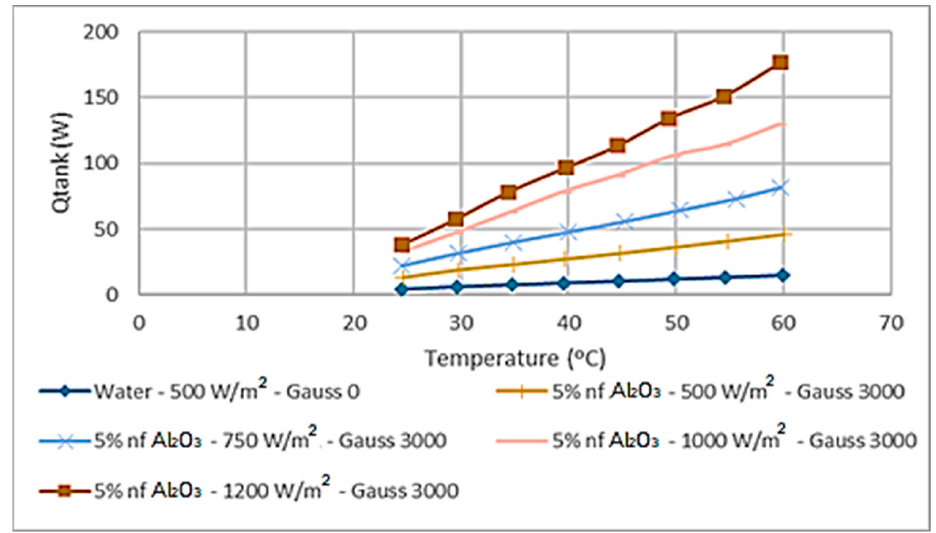
Figure 19. Thermal storage tank thermal energy generated by PV-Th solar panels with different solar radiations.